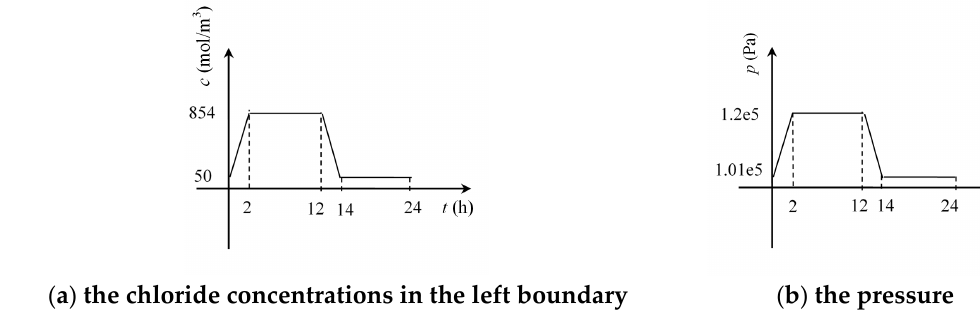
Figure 5. Boundary conditions.